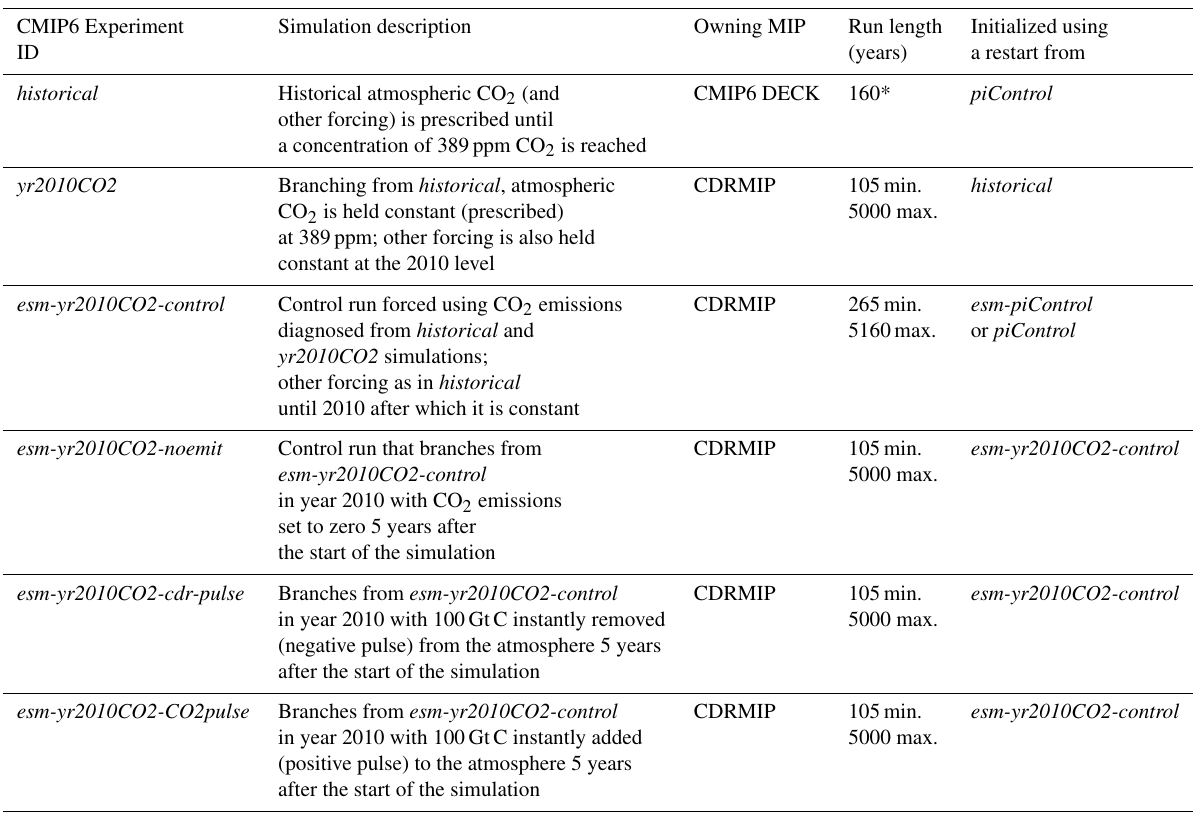
Table 4. Instantaneous CO 2 removal from a perturbed climate experiment ( CDR-yr2010-pulse ) simulation. All simulations are required to complete the